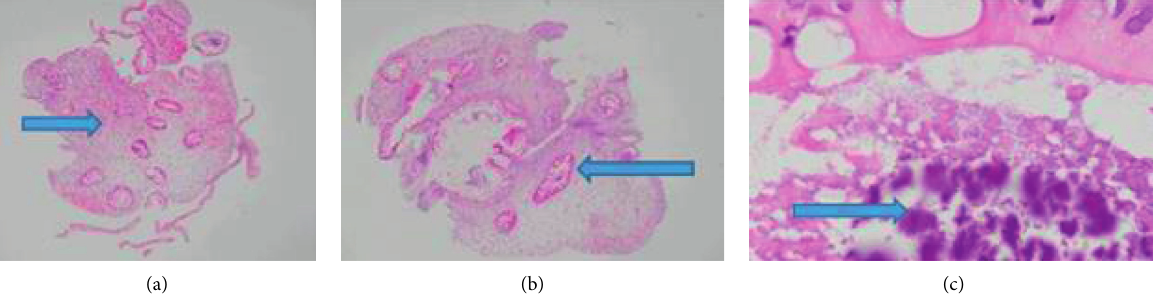
Figure 5: Histologic findings of colon biopsy; all pieces of the colonic polyps show (a) edematous lamina propria, crypt dropout, and mononuclear infiltrates, (b) crypts lined by reactive columnar cells, and (c) bacterial colonies.